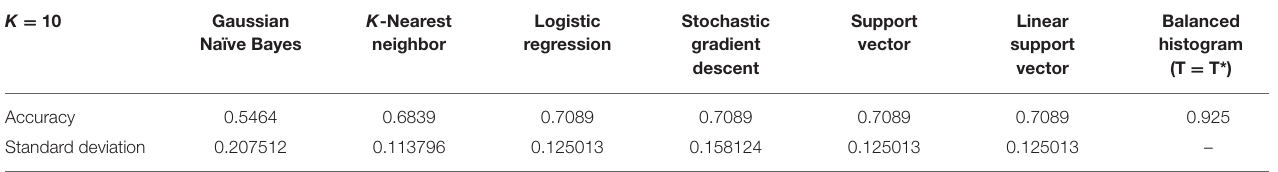
TABLE 2 | Performance comparison to machine learning classifiers. K =